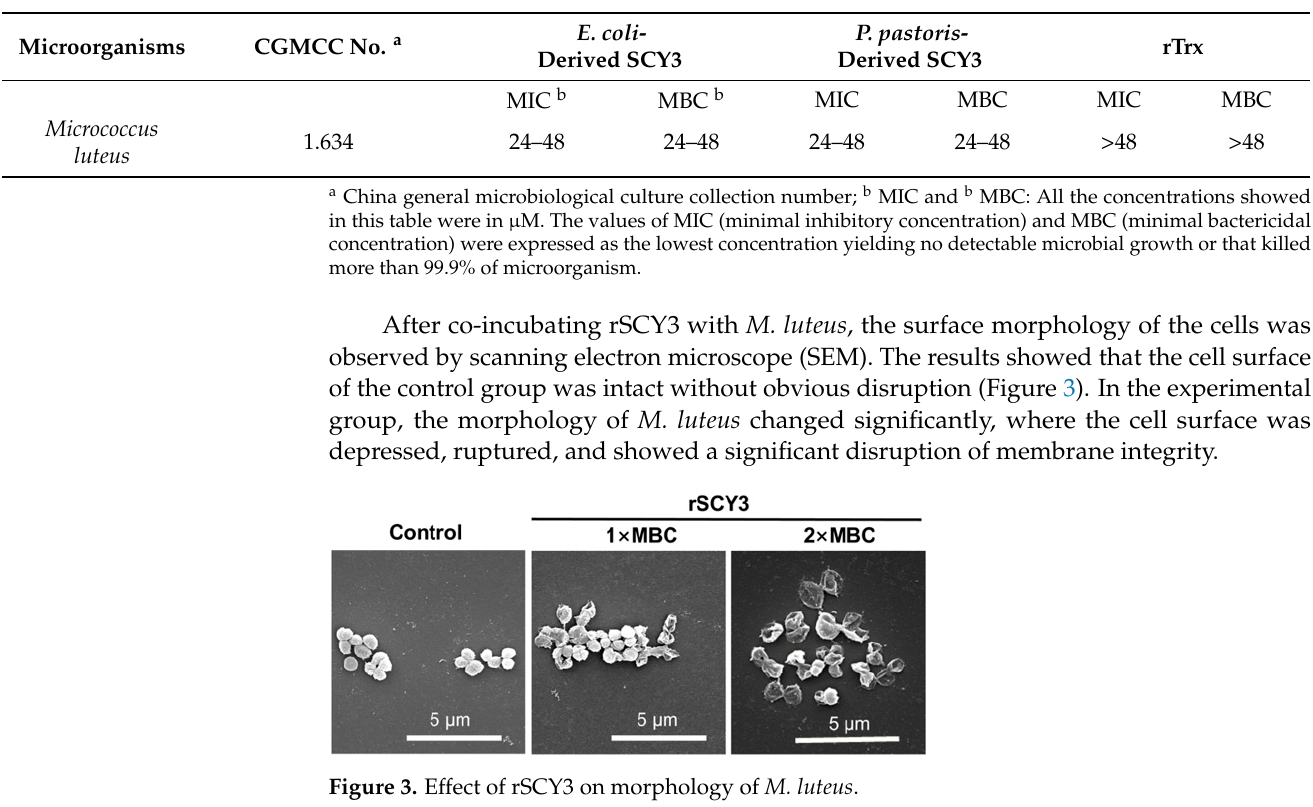
Table 1. Antibacterial activity of rSCY3.